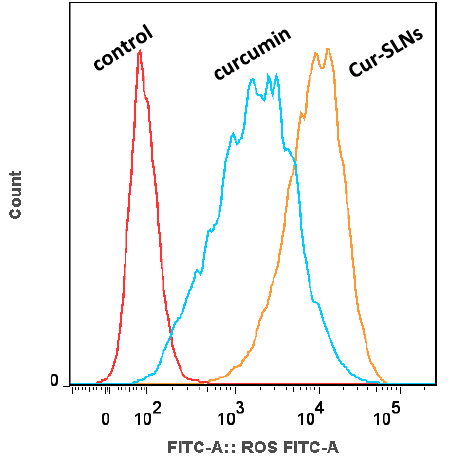
Figure 4. Dichlorodihydrofluorescein diacetate (DCFH-DA)/DCFH assay performed for the detection of Reactive Oxygen Species (ROS) generation by Cur and Cur-SLNs in SKBR3 cells.